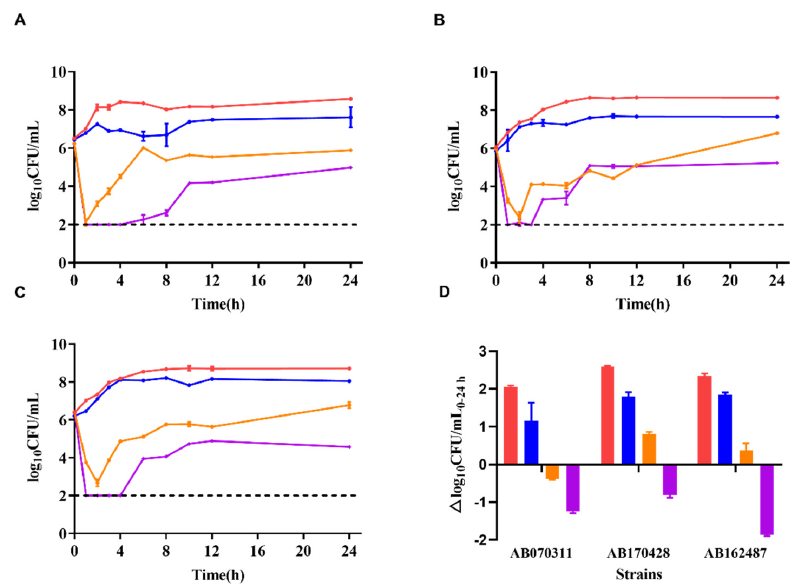
Figure 2. Time-kill curves of polymyxin B and minocycline alone and in combination against CRAB strains in a dynamic PK/PD model. ( A ): Time-kill curves of AB070311, ( B ): time-kill curves of AB170428, ( C ): time-kill curves of AB162487, ( D ): colony counts changed in the range of 0–24 h; red lines or column: bacterial growth curve; blue lines or column: minocycline 100 mg via 2 h infusion; orange lines or column: polymyxin B 0.75 mg/kg via 2 h infusion; purple lines or column: minocycline 100 mg combined polymyxin B 0.75 mg/kg via 2 h infusion; dash line: the detection limit.